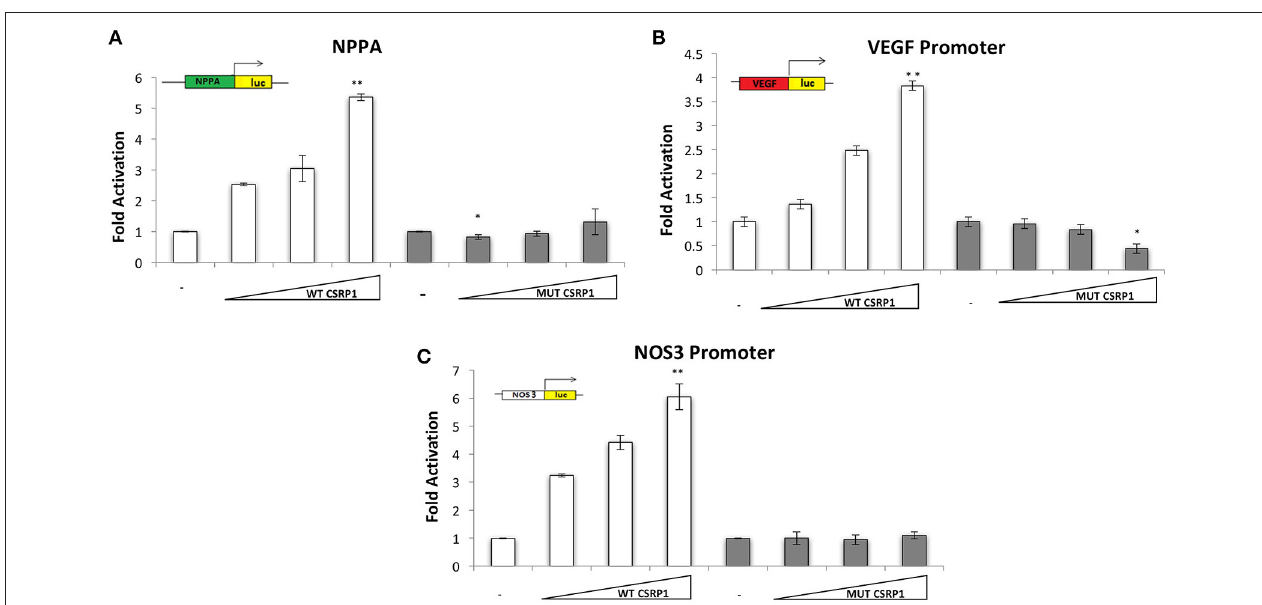
FIGURE 3 | Transcriptional activity of WT and/or MUT CSRP1. (A–C) WT or MUT CSRP1 was transiently transfected along with 3.5 µ g of NPPA, VEGF, and NOS3-luciferase promoters respectively in HEK293 cells. Relative luciferase activities were presented as fold changes. The data represent the means of 3 independent experiments done in duplicates and the values are ± SE. P -value was assessed used Students’ T -test. Significance p < 0.01 is indicated by an (**) while p < 0.05 is indicated by (*); significance is tested relative to control. The triangle represents an increasing dose of the WT and MUT CSRP1 (200, 400, and 600 ng, respectively).